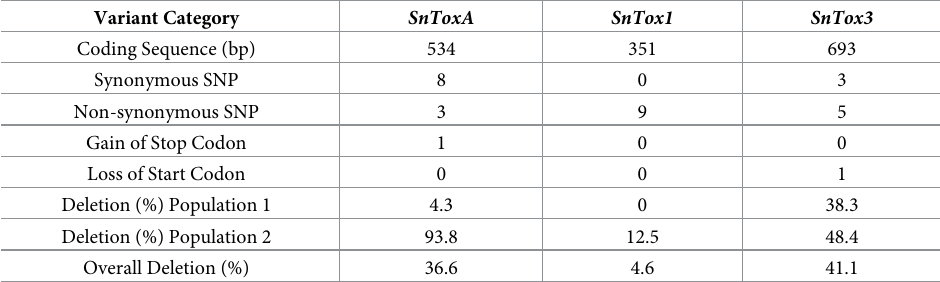
Table 4. Functional variants identified in SnToxA , SnTox1 , and SnTox3